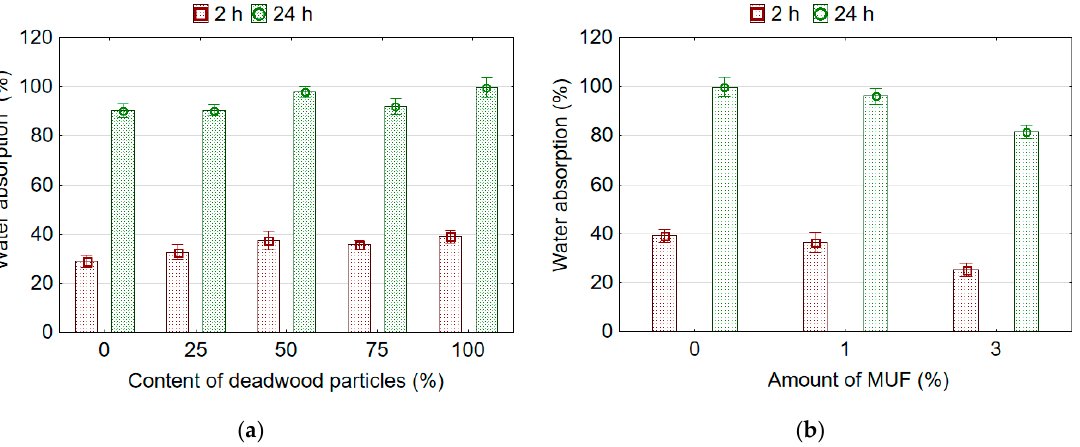
Figure 4. Water absorption of boards samples depending on content of deadwood particles ( a ) and amount of MUF resin in adhesive ( b